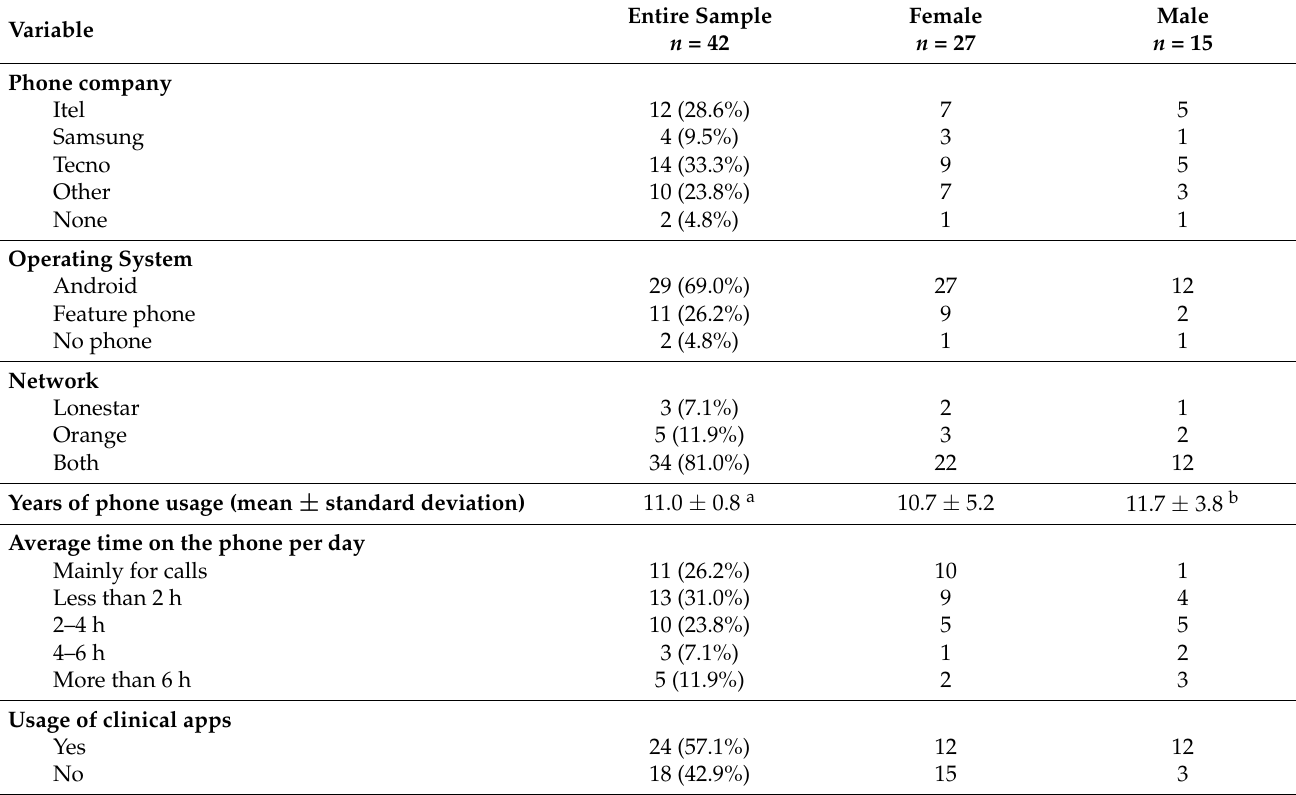
Table 3. Reported mobile phone expertise and the use of mobile phones by study participants disaggregated by